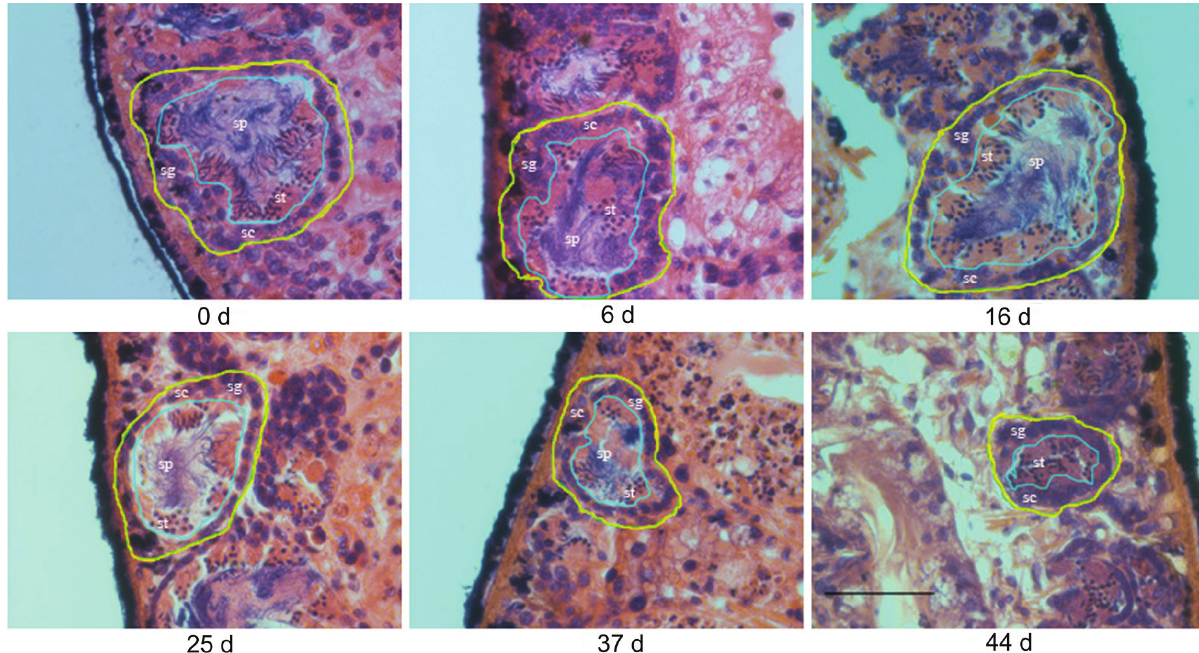
Figure 2. Sagittal section of testis during starvation. The blue lines indicate the innermost region and the yellow lines indicate that the border between the testis region and the surrounding tissue. d: days after starvation, sg: spermatogonium, sc: spermatocyte, st: spermatid, sp: spermatozoa. Scale bar: 100